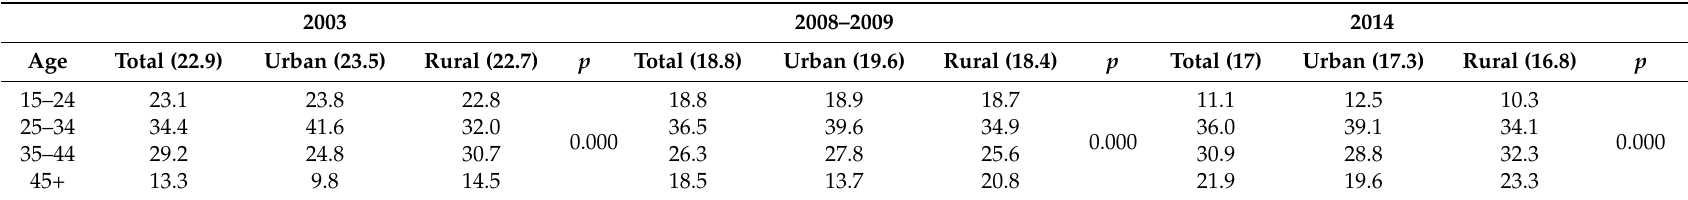
Table 2. Trends in the prevalence (%) of smoking among men aged 15 years and above in Kenya. Kenya Demographic and Health